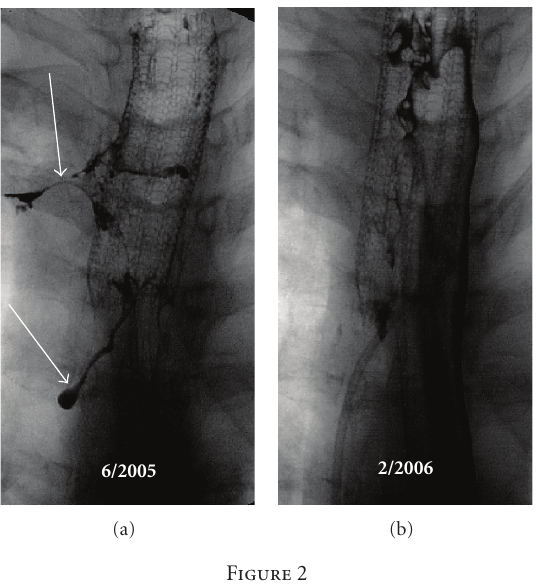
and gaining over 5 kilograms. Restaging CT scans demon- strated a near complete resolution of her mediastinal disease and fistulae, and no other disease was noted. A posttreatment PET/CT demonstrated a non-FDG avid residual mediastinal mass. At restaging imaging 3 months later, the mass persisted unchanged and the patient declined biopsy or further inter-